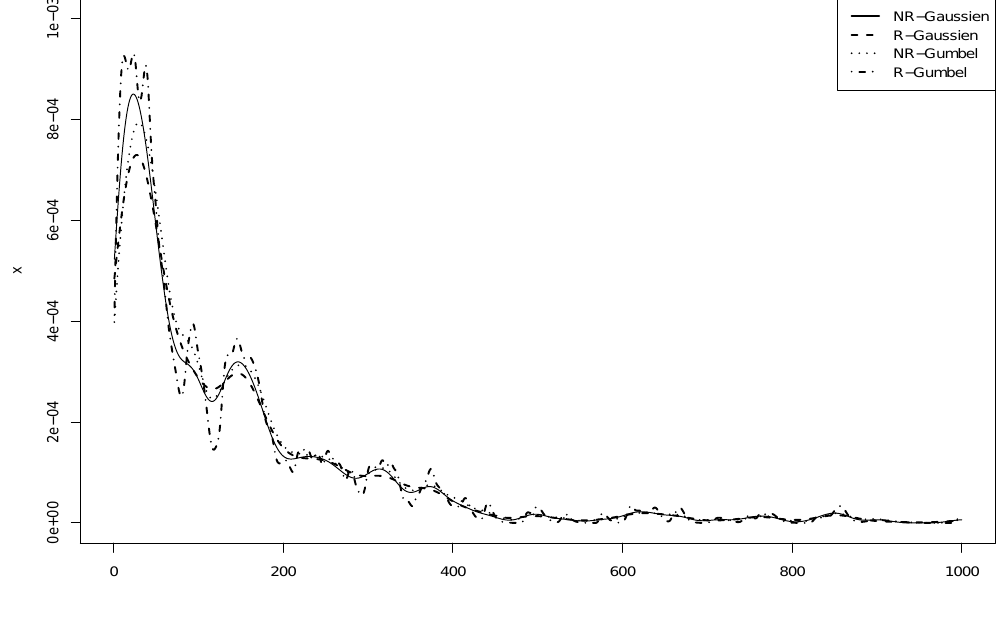
Figure 3: Qualitative comparison between the four considered estimators. Here we consider the caniapiscau dataset of the package FlowScreen